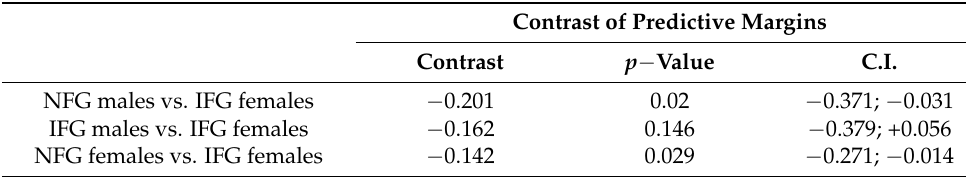
(Table 4): when analyzing the contrast between the interaction categories, the Pr(TN) in the IFG females was significantly higher than the Pr(TN) in both the NFG males and NFG females but not the IFG males (Table 5 and Figure 1). Table 5. Analysis of the contrast between the predicted probability of having TN (Pr(TN)) in IFG females vs. the other interaction